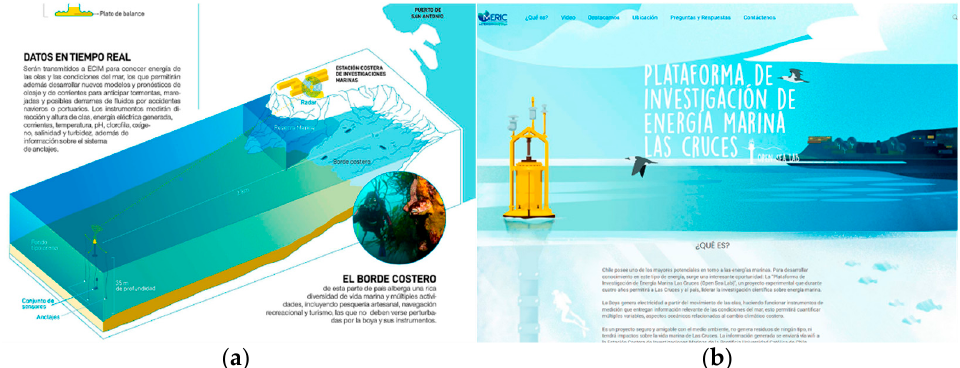
Figure 6. ( a ) Flyer for the scientific community. ( b ) OSL landing page for local stakeholders. Both in Spanish, for reference only.